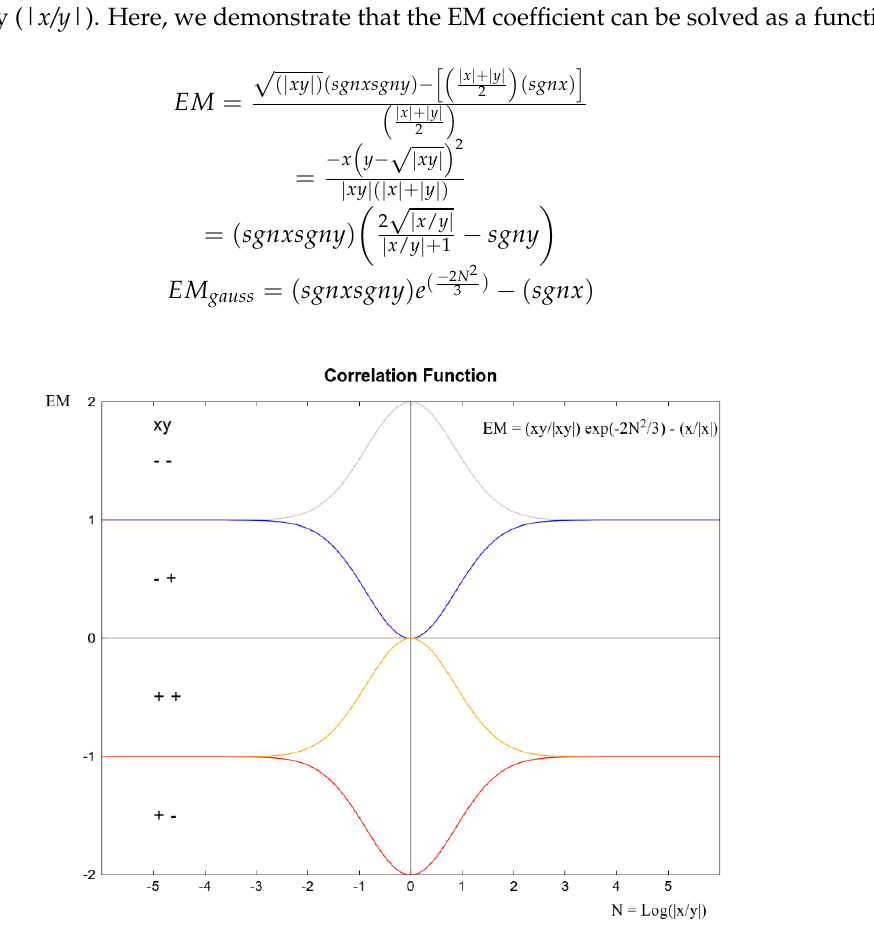
Figure 4. Graphical representation of the EM correlation coefficient (Equation (3)), a Gaussian function of the logarithmic ratio between x and y absolute values ( N ).